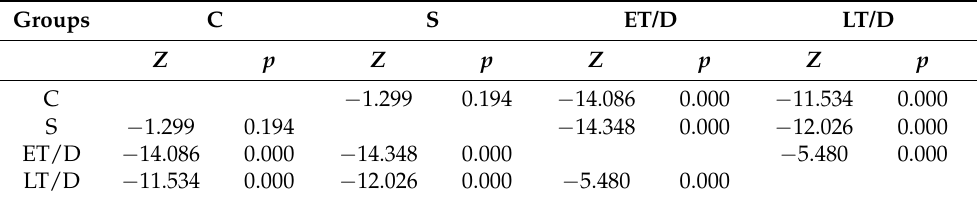
Table 2. Binary comparison results of the groups for mean AgNOR number.